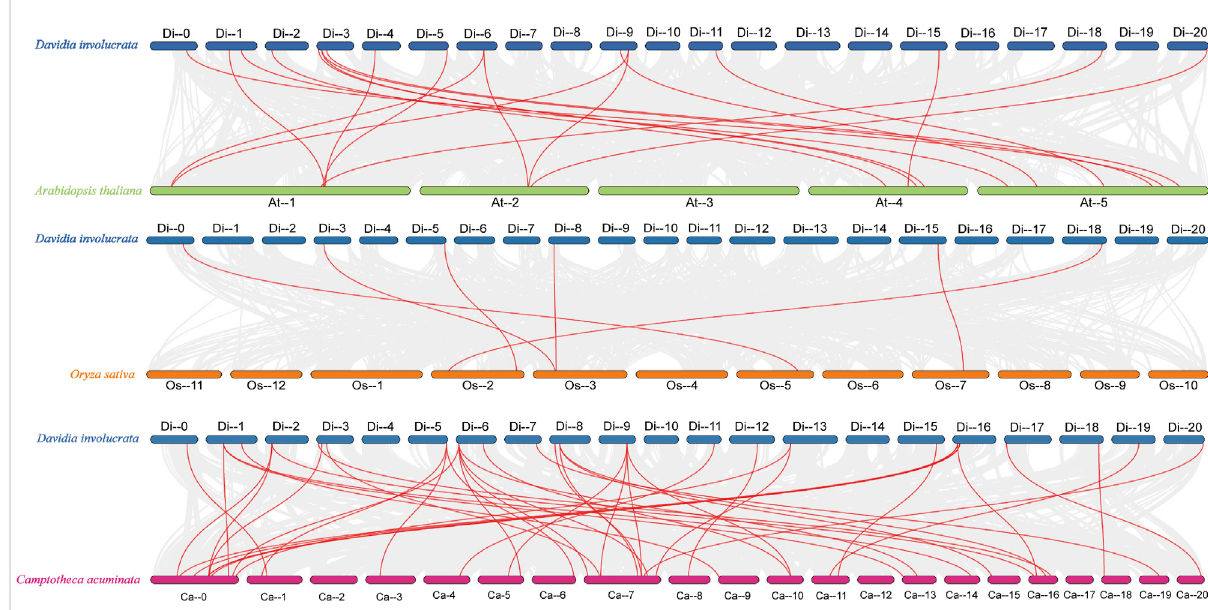
FIGURE 5 Synteny analyses of HSP20 genes between D. involucrata and three other representative plant species ( Arabidopsis , rice, C. acuminata ) (A) D. involucrata VS. A. thaliana . (B) D. involucrata VS. O. sativa . (C) D. involucrata VS. C. acuminata . Gray lines indicate signi fi cantly collinear blocks within and among plant genomes, while red lines highlight syntenic HSP20 gene pairs. The chromosome number is indicated at the top of each